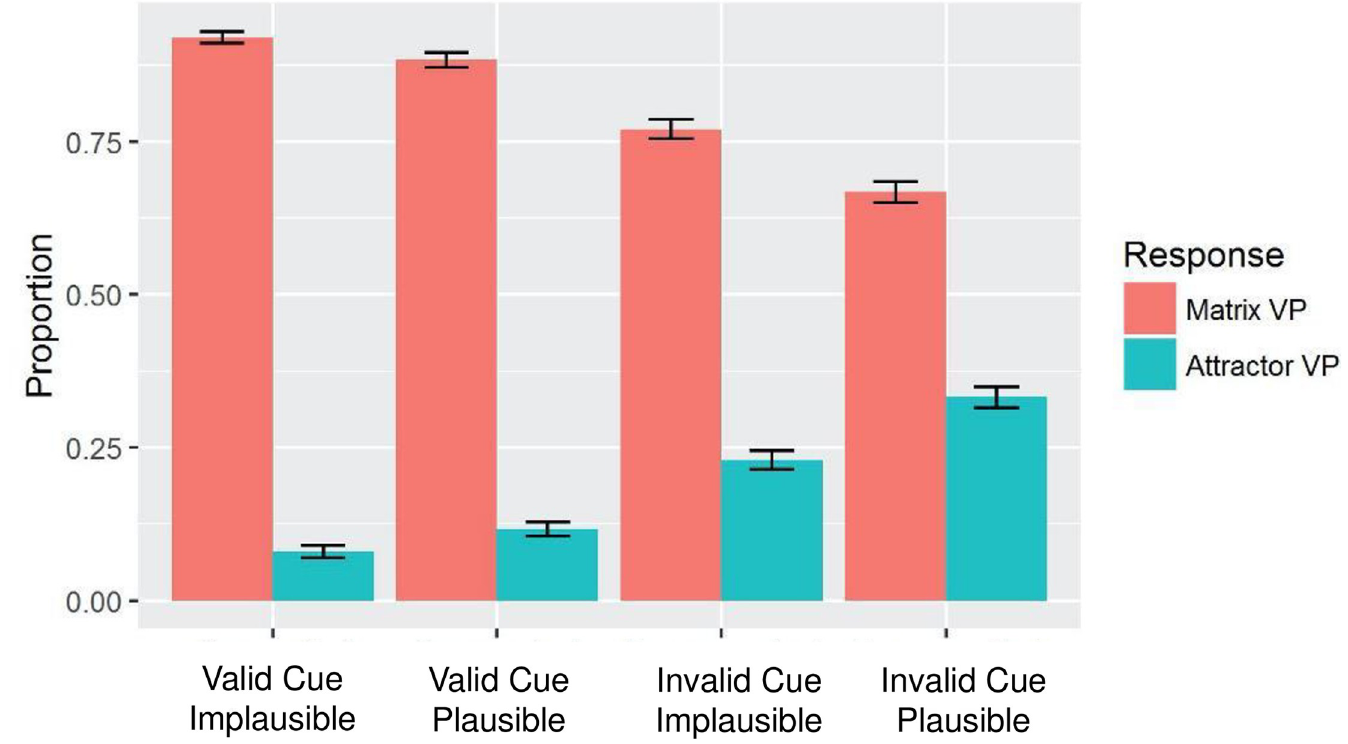
Fig 2. Proportion selected in 2AFC task as a function of